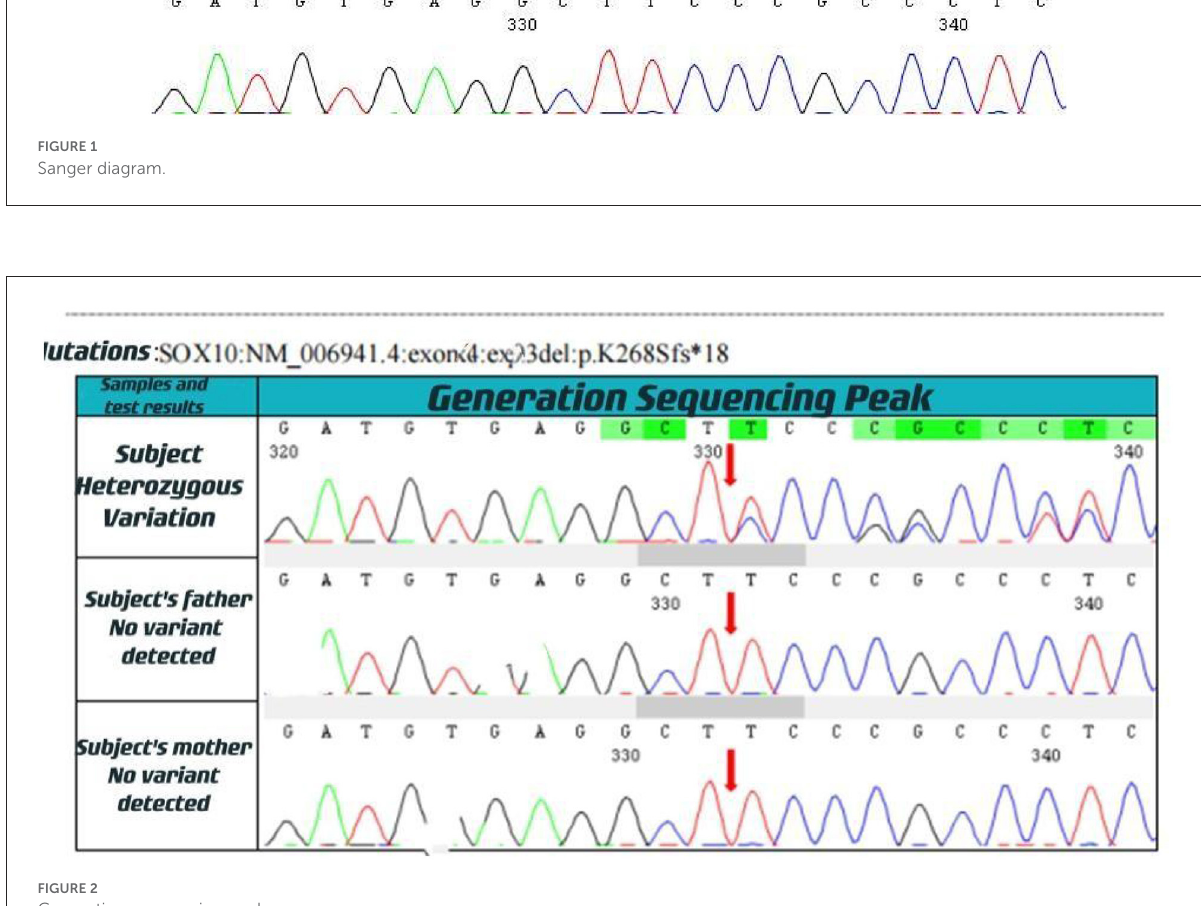
FIGURE2 Generation sequencing